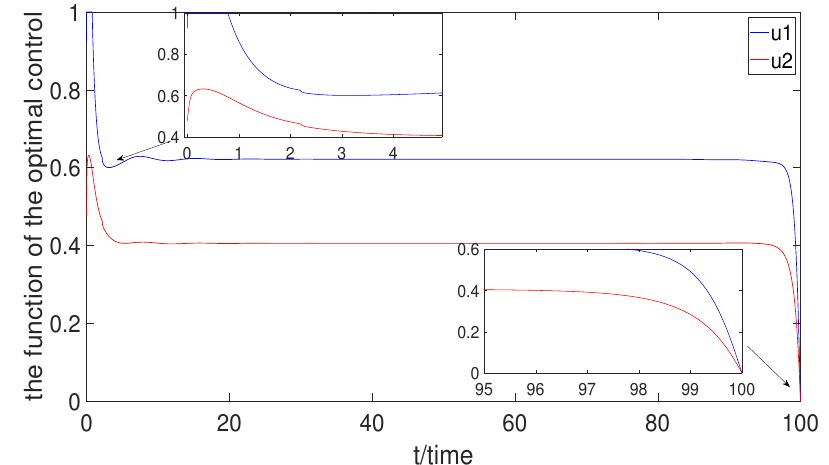
Figure 6. The optimal control curves when τ = 2.2.